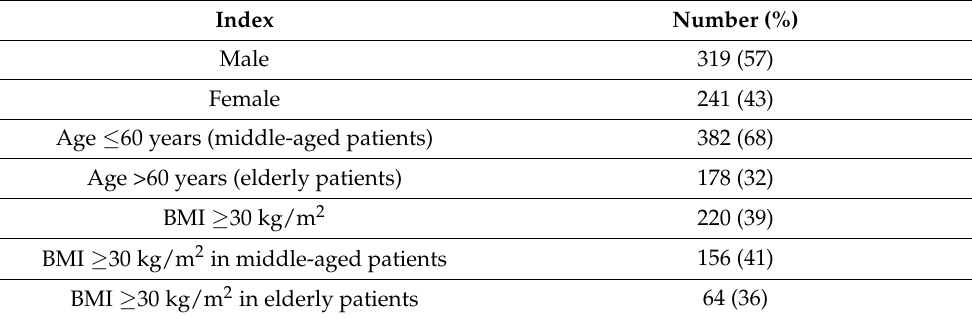
Table 1. Characteristics of patients included in the